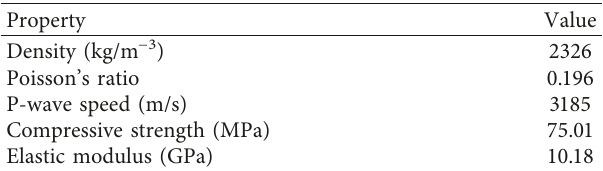
Figure 2: Specimen: (a) conventional specimen (specimen A) and (b) specimen with a hole (specimen B). Table 1: Physical-mechanical parameters for sandstone under static